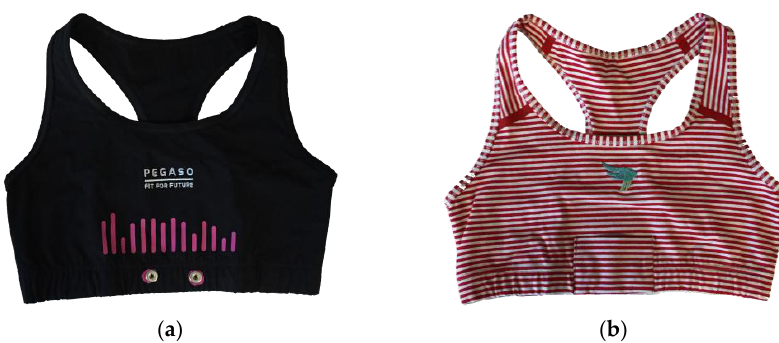
Figure 4. The comparison of the two female versions of the first set of sensorized bras: ( a ) the style with technical textile and the visible device to be attached to the two snap buttons; ( b ) the style with a more fashionable colour and the sensing device hidden into the pocket where the two connecting snap buttons are placed.